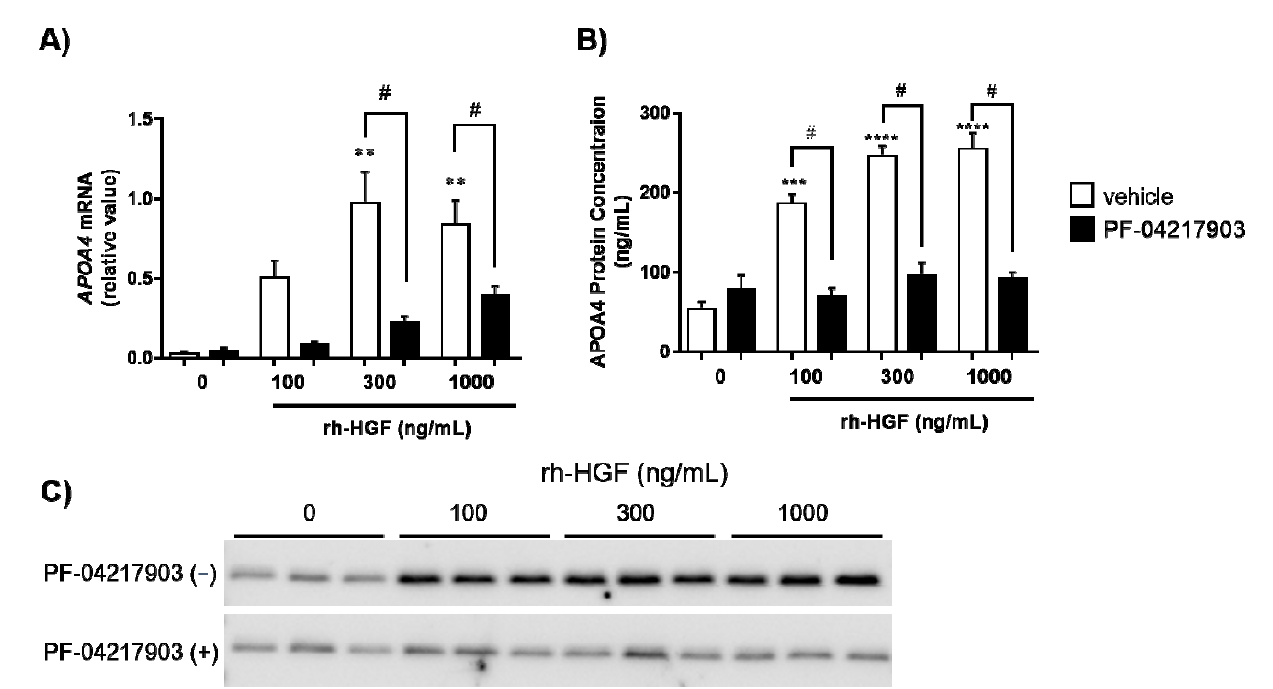
Figure 1. Induction of human APOA4 by rh-HGF, and its c-Met dependency. ( A ) Relative expression of APOA4 mRNA compared to the expression of 18S rRNA in human hepatocytes, ( B ) Relative concentration of APOA4 protein in supernatants ** p < 0.01, *** p < 0.001, **** p < 0.0001: comparison between vehicle control (incubation medium) or rh-HGF alone-treated group (Dunnett’s test). # p < 0.05: comparison between rh-HGF alone-treated group and PF-04217903-rh-HGF co-culture group (unpaired t test). The data are presented as mean ± SEM ( n = 3). The median value of the triplicate analyses was used for calculation. ( C ) Analysis of APOA4 protein levels in the supernatants of the culture using Western blot. The picture shows a representative batch of hepatocytes in triplicate.